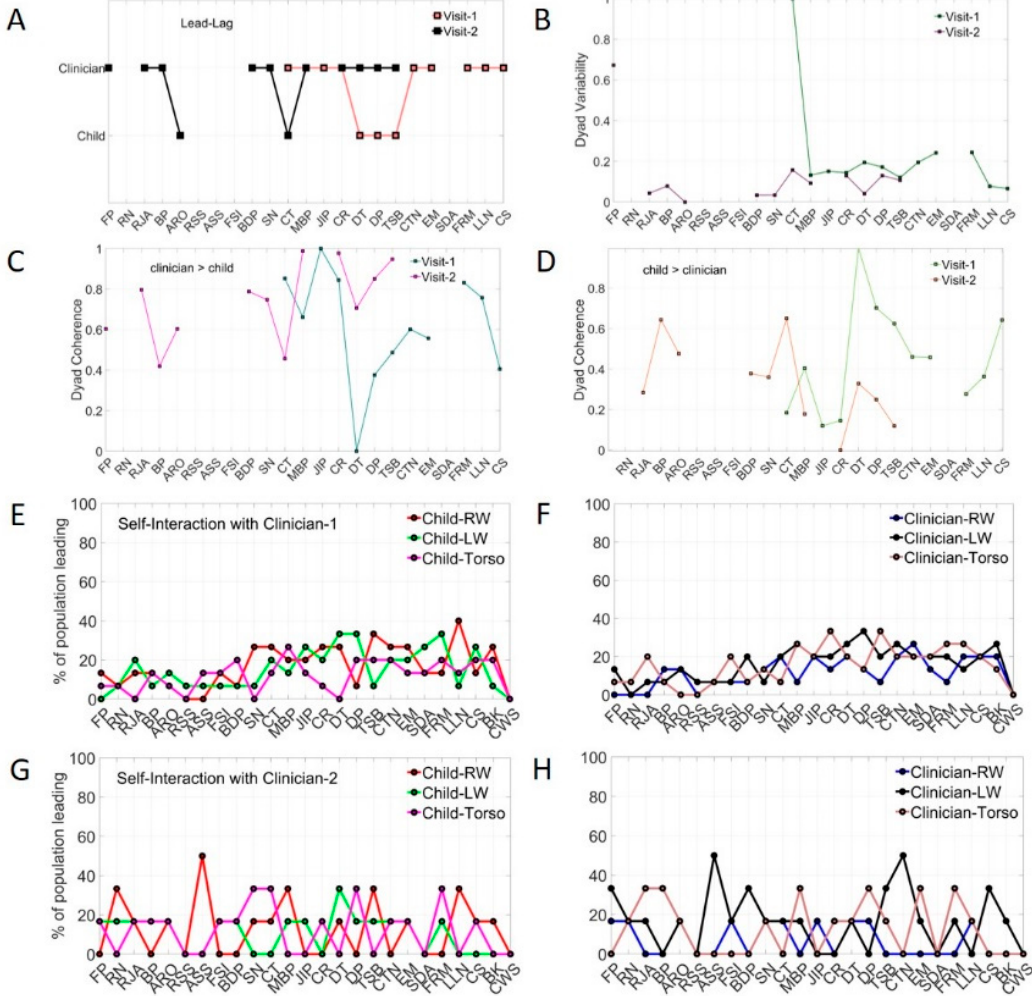
Figure 6. High sensitivity of micro-level metrics captures socio-motor changes over time and serves to measure rater’s reliability-style. ( A – D ) ADOS scoring system does not capture change in developmental socio-motor physiology. Across visits, the macro-level scores remain static, but the micro-level socio-motor parameters change. These include leading profile, Dyadic Variability and Dyadic Coherence. ( E , F ) High sensitivity to changing clinician rater prevails across all children and tasks. The self-interaction parameters (individual kinematic synergies) of autistic participants are sensitive (at the micro-level) to changing the rater. ( G , H ) Leading profiles in the same autistic cohort shift as the raters differ.